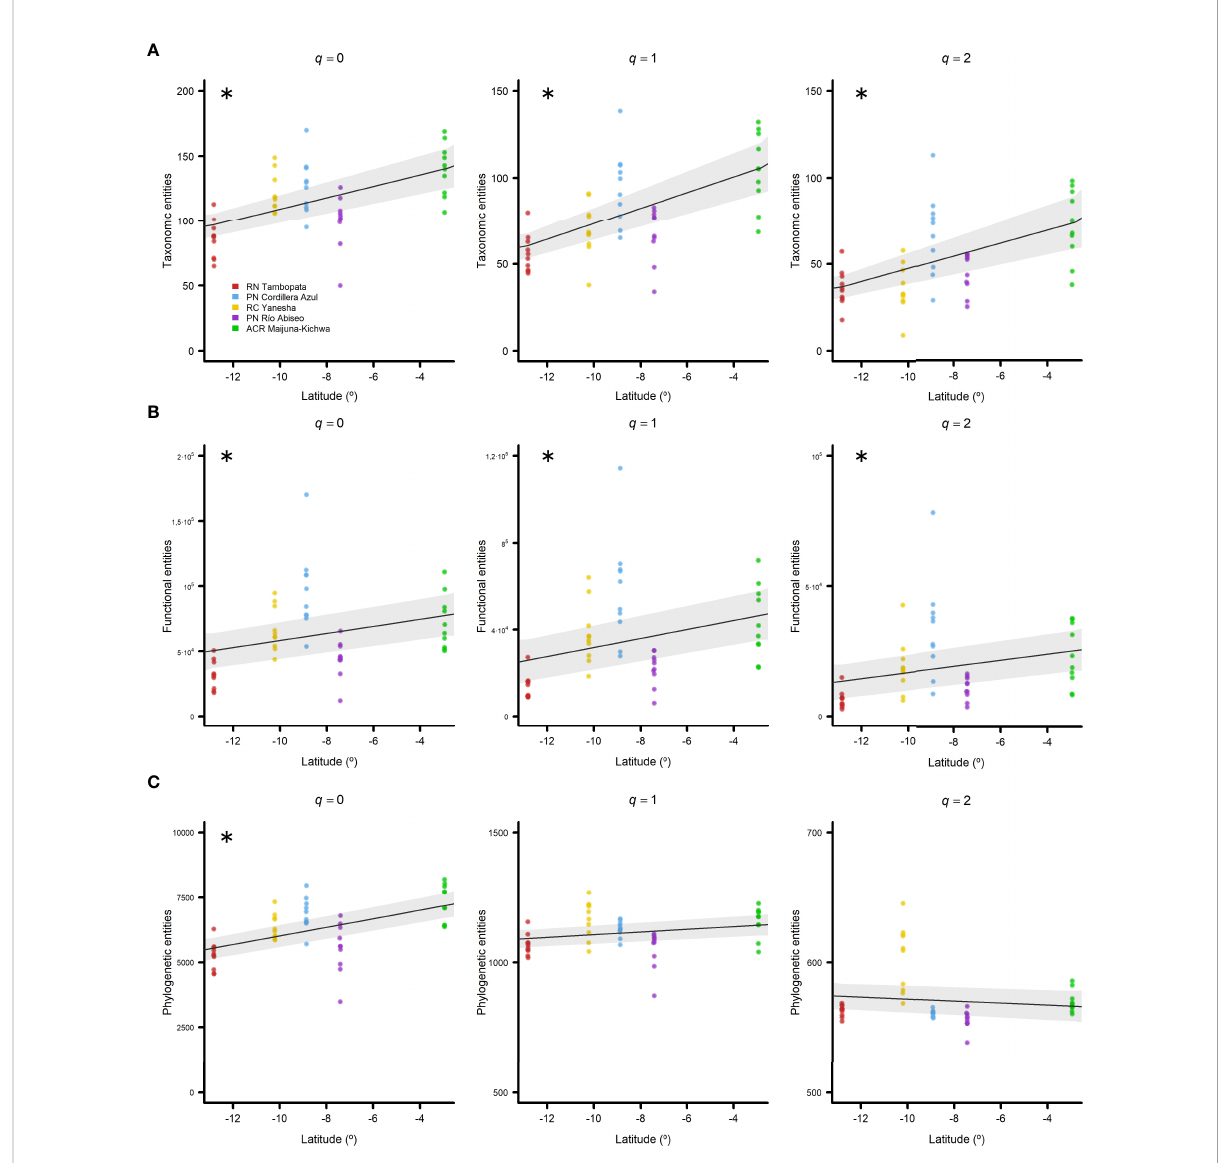
FIGURE 3 Diversity latitudinal trends for all fi ve regions studied in Western Amazonia represented by negative binomial generalized linear models (GLMs) with 95% con fi dence intervals. (A) Taxonomic, (B) functional, and (C) phylogenetic entities found against latitude in decimal degrees. Hill numbers were considered as diversity indexes: q = 0 (left column), q = 1 (central column), and q = 2 (right column). Regions are represented by different colours (see the legend). Signi fi cant pseudo R-squared ( pR 2 ) v alues are marked with